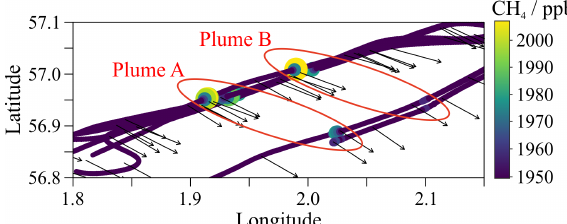
Figure B1. CH 4 mole fraction (see colour scale) measurements in the North Sea on 4 March 2019. Black arrows show the 60s mean wind direction. Two distinct emission plumes (containing enhance- ments in CH 4 , as well as CO 2 , NO x , and C 2 H 6 ) are shown, labelled Plume A and Plume B. Note that some of these peaks were removed from analysis due to a lack of measured data (primarily NO x ) either within the plume or within the background (see Appendix